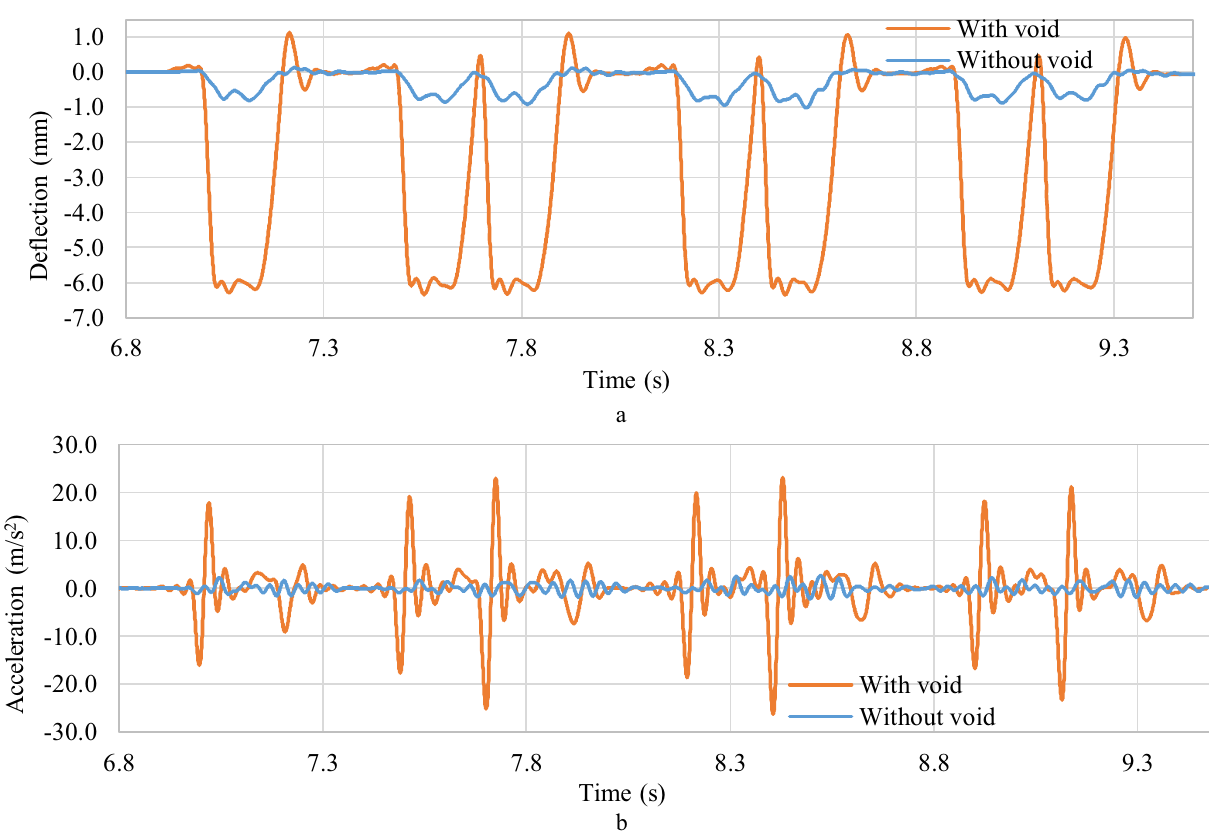
Fig. 7 Measured rail deflections ( a ) and accelerations derived from LVDT ( b ) in the voided zone (case 3) and the reference zone